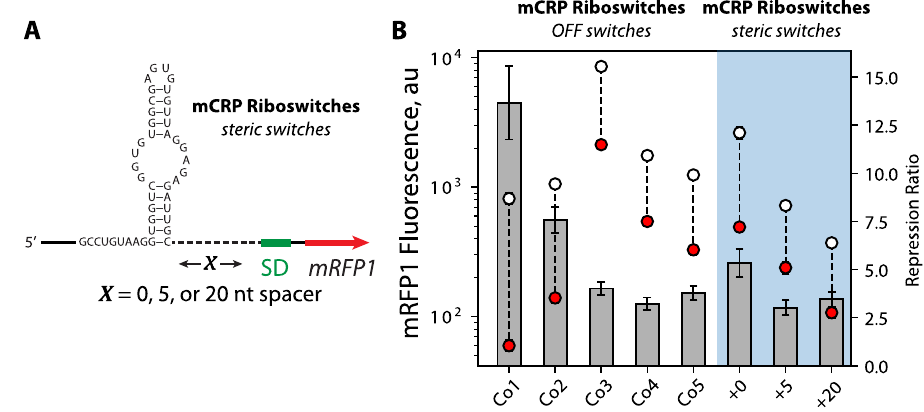
Fig. 5 | Placement of mCRP aptamer in the standby site of the 5 ′ UTR represses gene expression. A The sequence and structure of the mCRP-binding steric switches, showing the spacer length ( X ) separating the mCRP aptamer and a con- sensus Shine – Dalgarno sequence. B The repression ratios of the designed mCRP